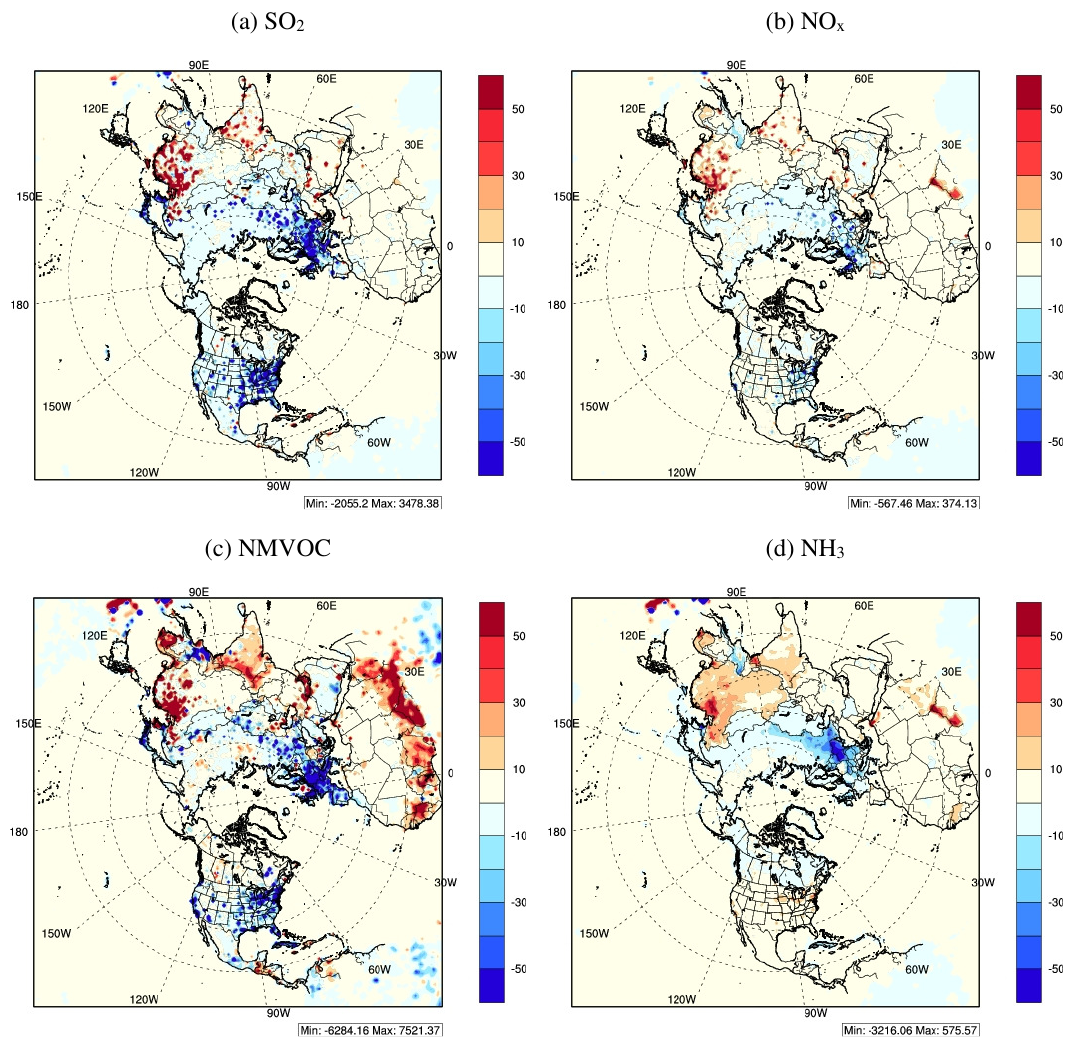
Figure 2. EDGAR emission trend over 1990 to 2010 for SO 2 , NO x , NMVOC and NH 3 (kgkm − 2 yr − 1 , computed on the basis of annual means over the 1990–2010 period with a linear least square fit